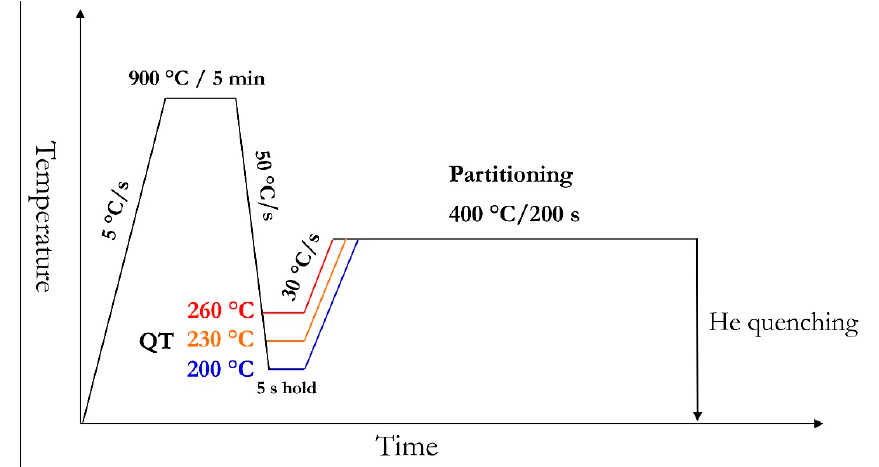
Figure 2. The three quenching and partitioning (Q&P) conditions studied by high-energy X-ray diffraction (HEXRD).